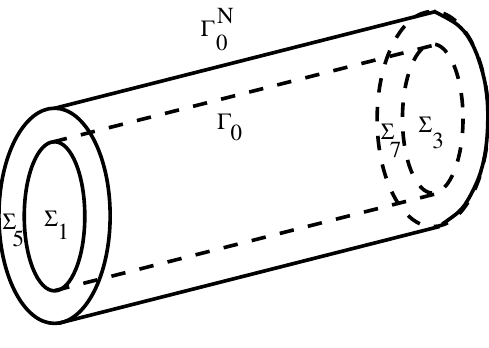
Figure 1. Initial geometrical